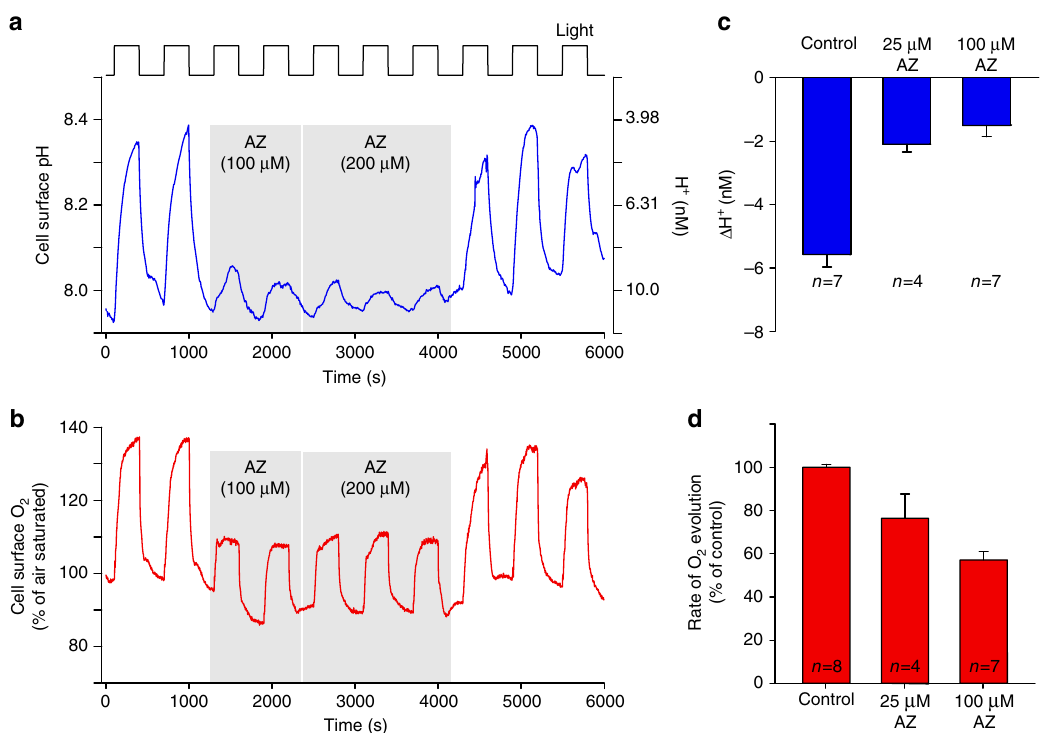
Fig. 3 Changes in cell surface pH in O. sinensis due to the activity of external carbonic anhydrase. a Acetazolamide (AZ), an inhibitor of external carbonic anhydrase (eCA), has a signi fi cant impact on cell surface pH. Light-dependent increases in cell surface pH were measured using a pH microelectrode. The addition of AZ largely inhibits the increase in cell surface pH. b Light-dependent increases in [O 2 ] for the cell shown in a . The addition of AZ substantially reduces the light-dependent increase in [O 2 ] around the cell. The inhibitory effect of AZ is rapidly reversed. c Mean changes in cell surface [H + ] after illumination for 300 s following treatment with AZ. d Mean rate of O 2 evolution relative to control following treatment with AZ. Error bars represent